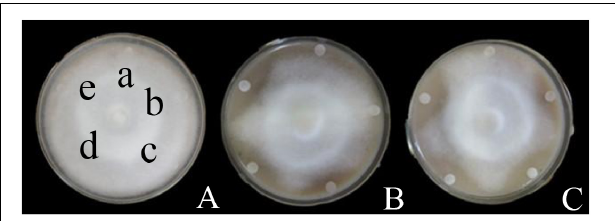
FIGURE 3 | Inhibitory effects of surfactin, Iturin A, and Fengycin A on P. infestans mycelium growth. (A) Surfactin; (B) Iturin A; (C) Fengycin A. The letter a represents the control (distilled water), and the lower-case letters b-e indicate drugs concentrations of 10, 15, 20, and 25 µ g/mL, respectively, the same in the (B,C)